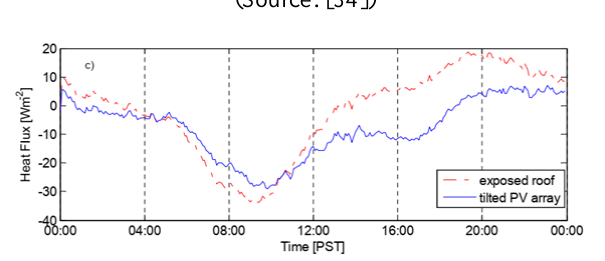
Fig. 12. Conductive heat flux from bottom roof layer to ceiling surface for the exposed roof and the tilted PV array (Source: [34])